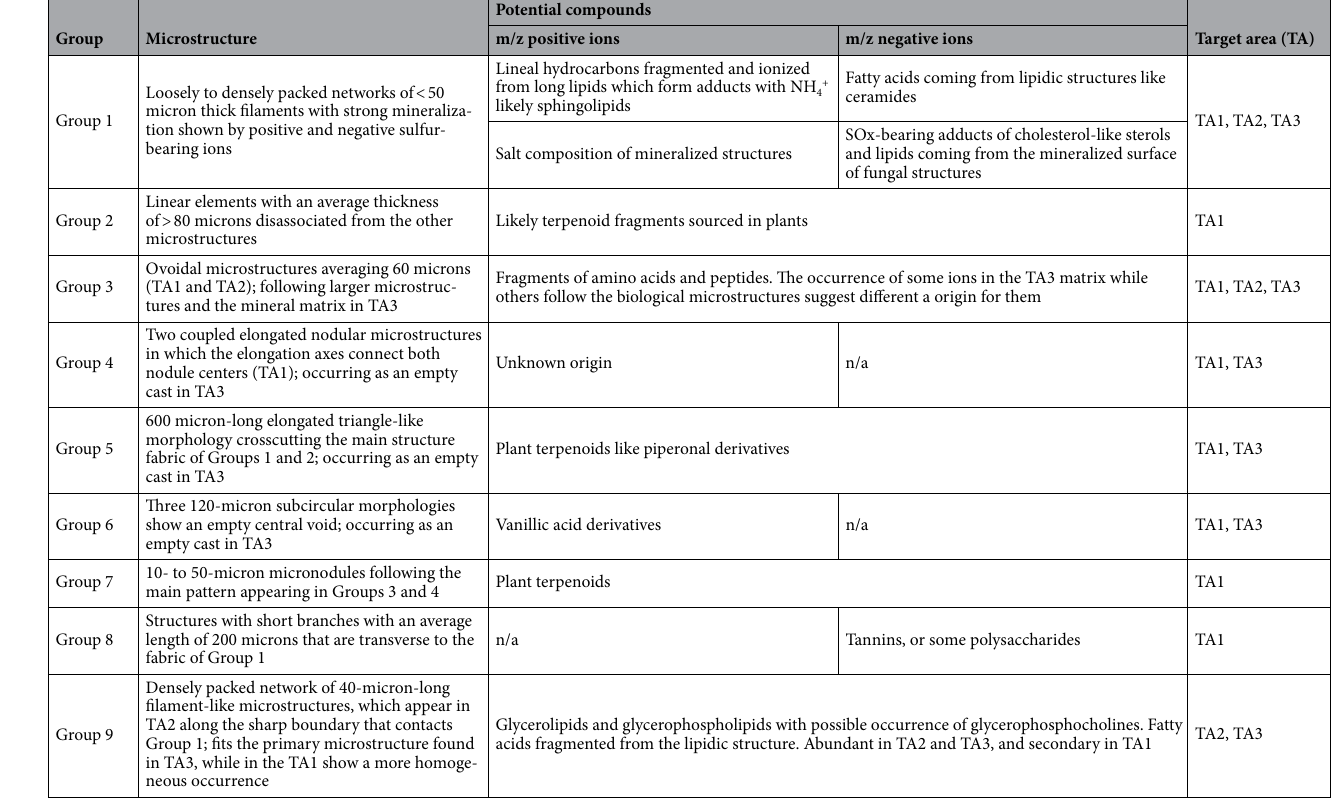
Table 1. Identification of the morphological groups through the ToF–SIMS molecular distribution found in the Upper Gossan sample of Peña de